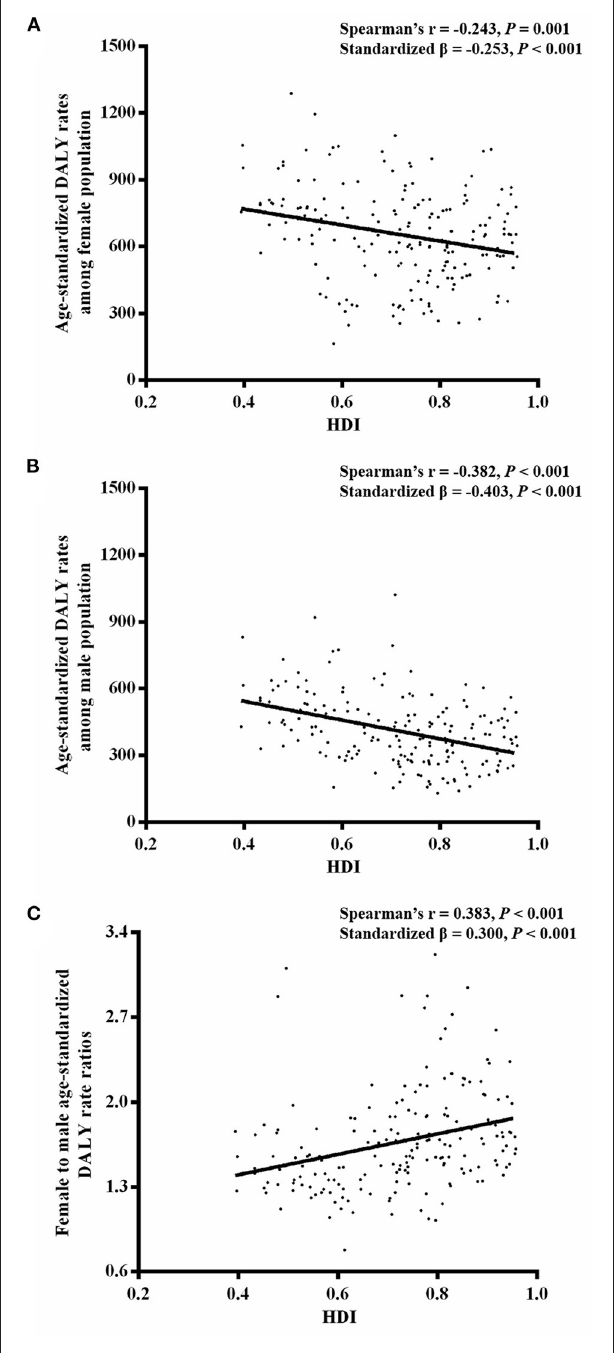
FIGURE 5 | Linear relationship (A) between national age-standardized DALY rates among female population and HDI, (B) between national age-standardized DALY rates among male population and HDI, and (C) between national female-to-male age-standardized DALY rate ratios and